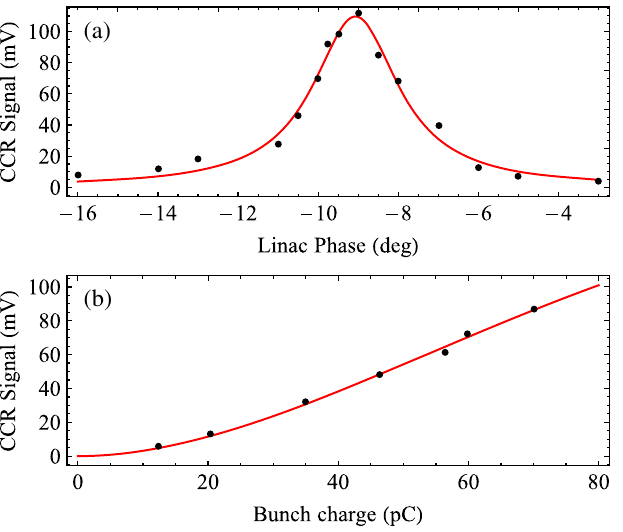
FIG. 2. Variation of CCR pulse energy with machine param- eters. (a) CCR signal as a function of the linac off-crest phase at bunch charge of 90 pC and 2 a ¼ 540 μ m. (b) Dependence of the CCR energy on bunch charge at maximal bunch longitudinal compression; 2 a ¼ 590 μ m.